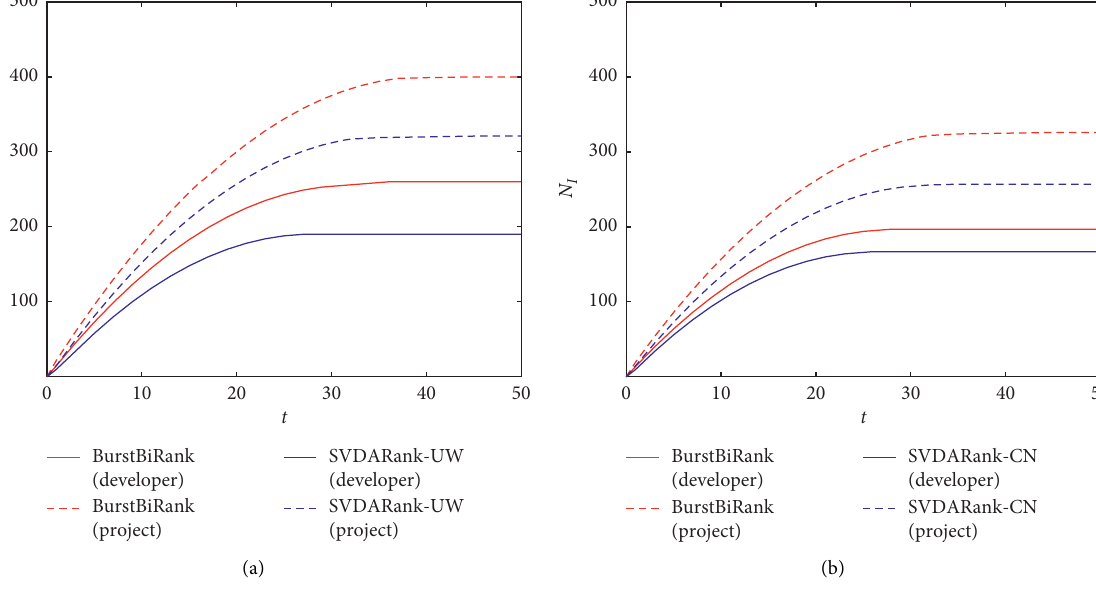
Figure 7: Performance comparison between BurstBiRank and SVDARank. (a) BurstBiRank vs. SVDARank-UW. (b) BurstBiRank vs.